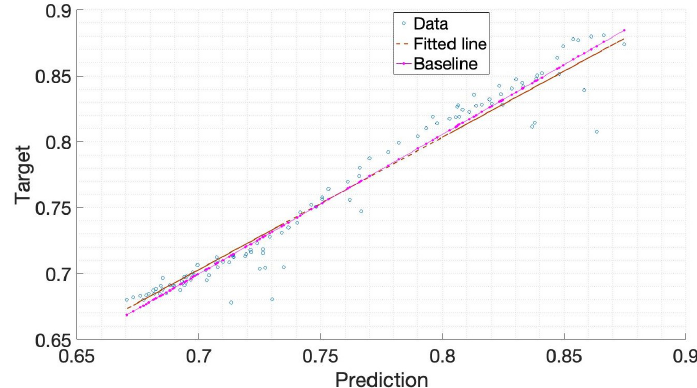
Figure 13. The regression line of output and real